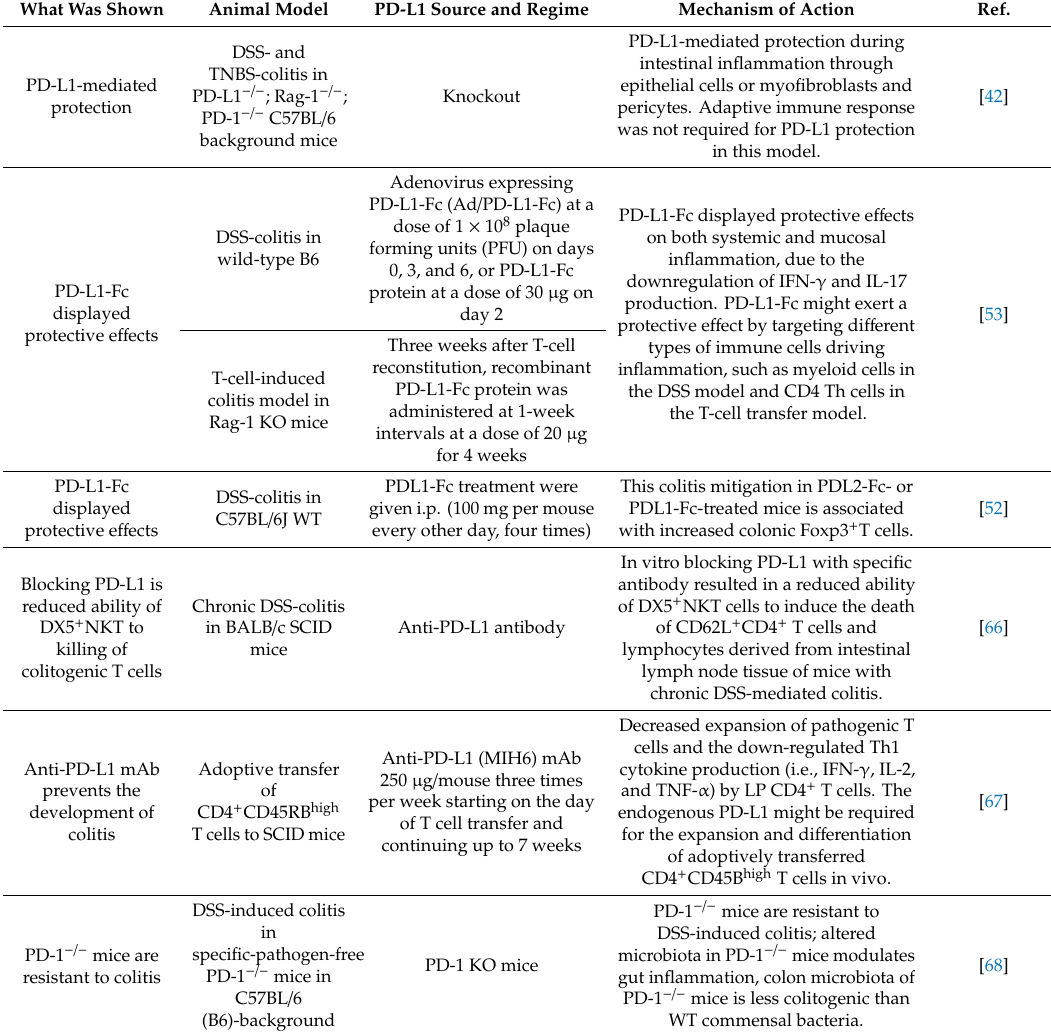
Table 1. Summaries of studies on the role of PD1 / PD-L1 in gastrointestinal